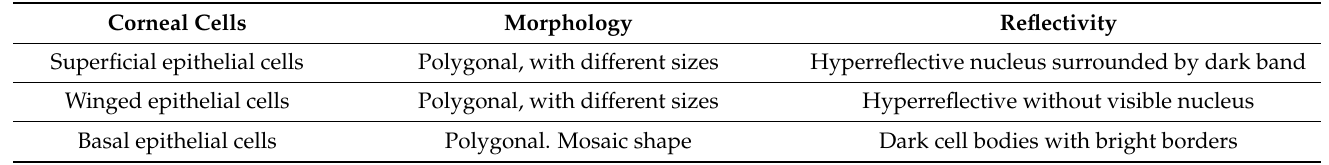
Table 2. Normal corneal cells morphology with